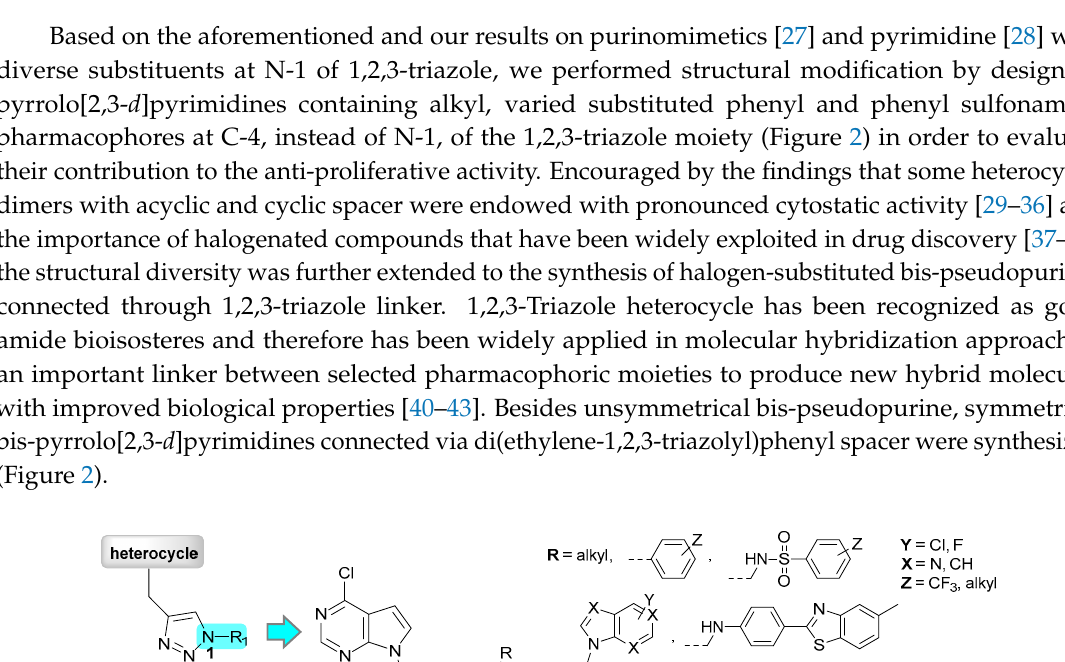
Figure 1. ( R )-Roscovitine and purine isosteres as small-molecule inhibitors of CDK (cyclin-dependent kinases) under clinical evaluations for the treatment of cancer.